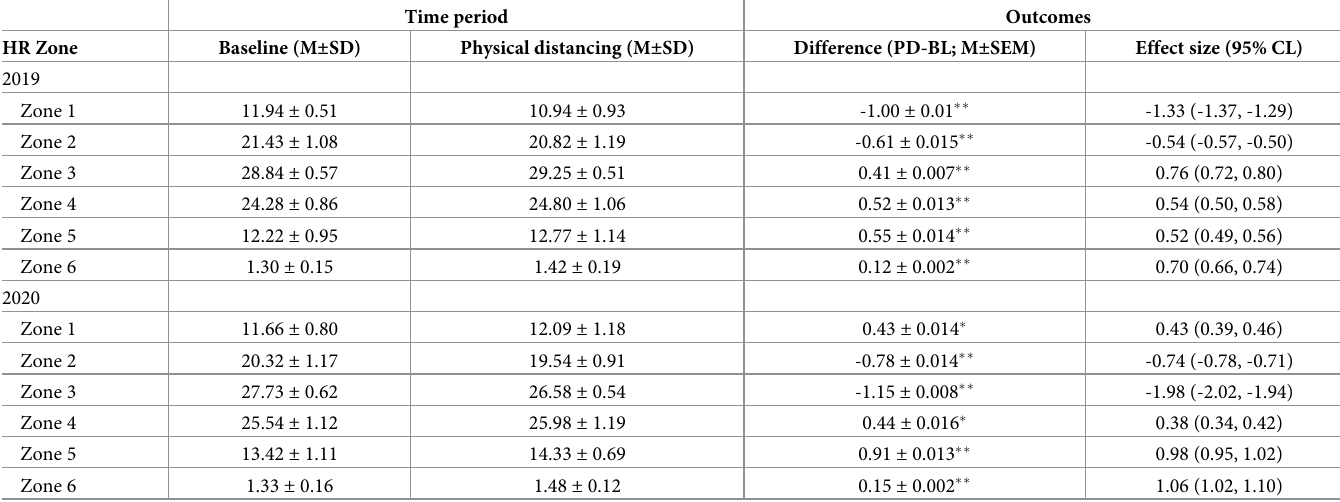
Table 4. Distribution of exercise intensity as a function of time